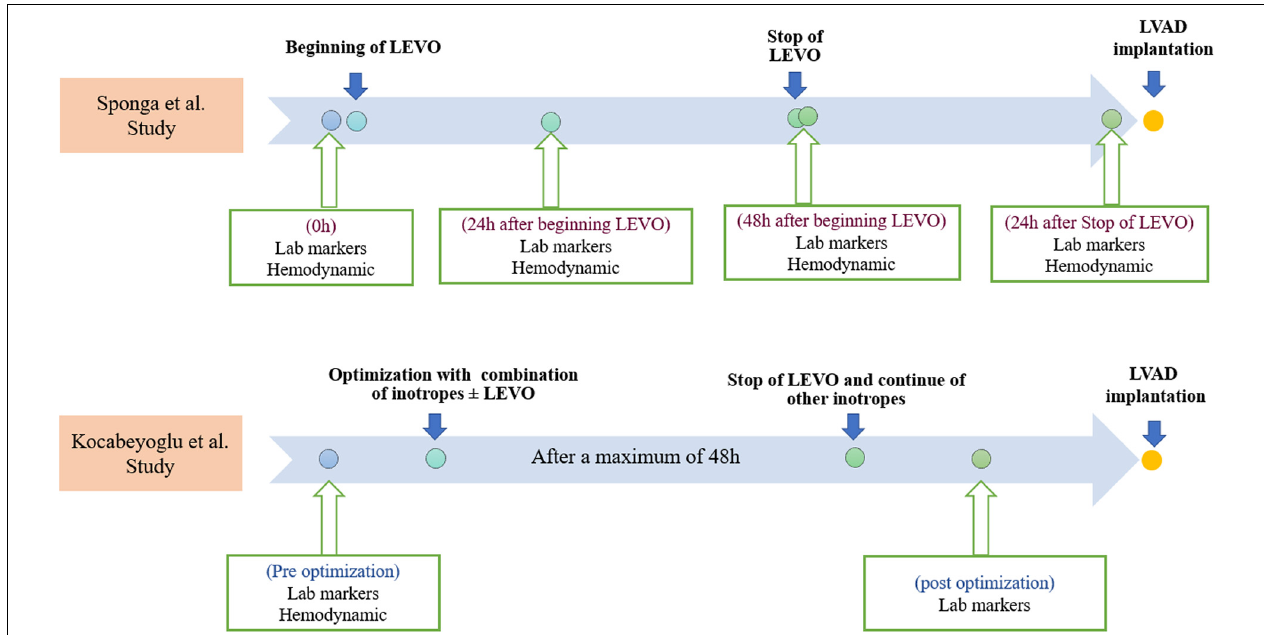
FIGURE 2 | Timelines of Levosimendan infusions, laboratory markers, and hemodynamic measurements in both studies. Lab, laboratory; LEVO, levosimendan; LVAD, left ventricular assist device.